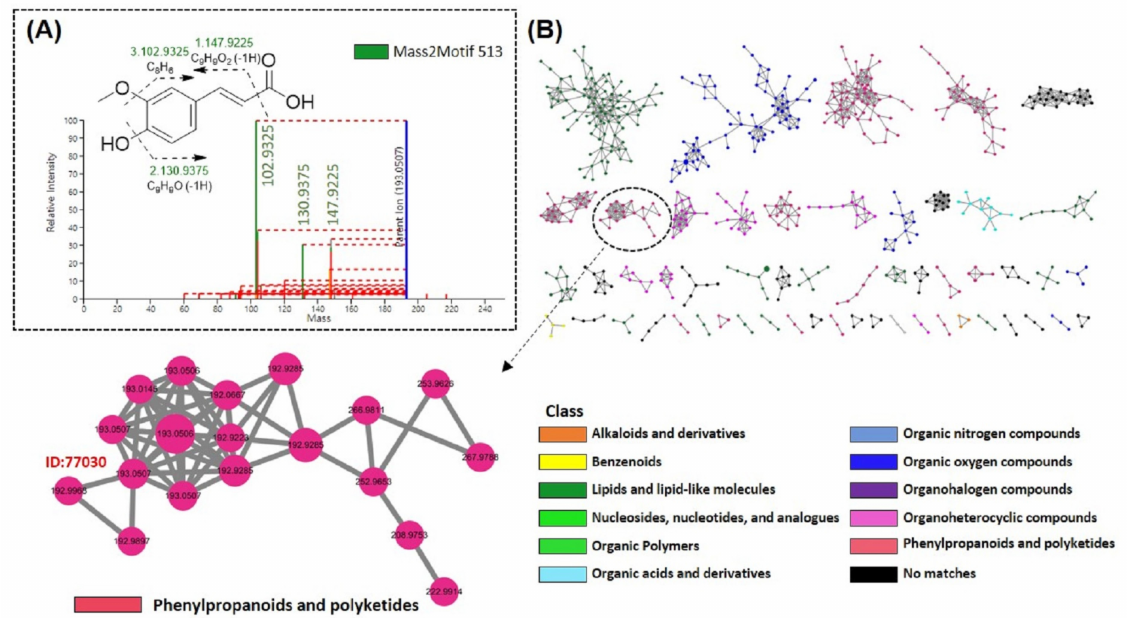
Figure 6. MS2LDA and MolNetEnhancer analysis of FMSE extract, MC, and MC5 fractions. ( A ) MS2LDA-driven fragment patterns of the top ranked NAP candidate. ( B ) Molecular network of all the detected features (three or more connected nodes of a graph), expanded for component index 29 containing feature ID